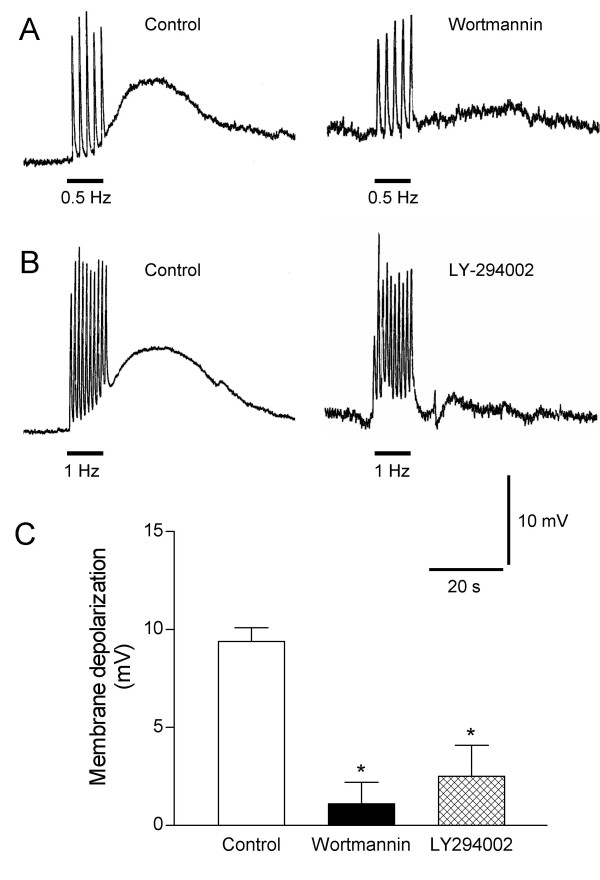
The PI3K inhibitors wortmannin and LY-294002 inhibit the EFS-induced slow membrane depolarization in canine isolated mesenteric vein. Intracellular recordings of membrane potential in response to EFS (0.1 ms, 13 V, 10 s) in canine isolated mesenteric veins preincubated for 60 min prior to and throughout the EFS with 100 nM wortmannin (A) or 10 μM LY-294002 (B). The experimental data are presented as mean ± SEM, n = 3–4 (C). *, P < 0.05 vs control. Scale bars apply to traces A and B.